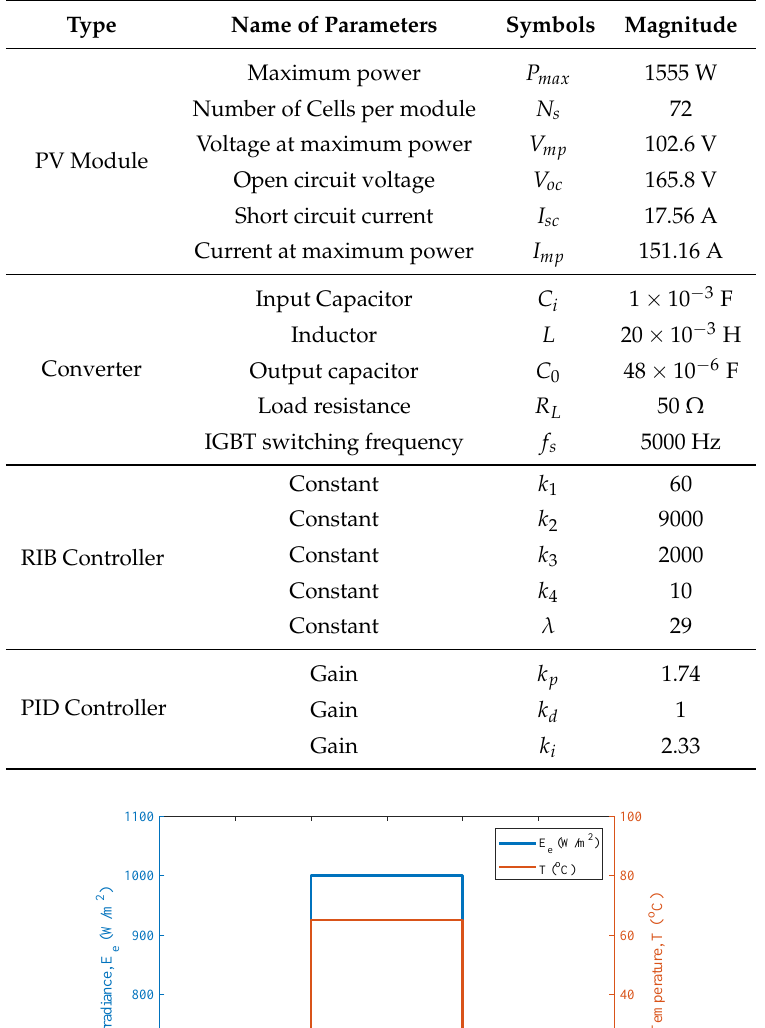
Table 1. Parameters of the PV system.